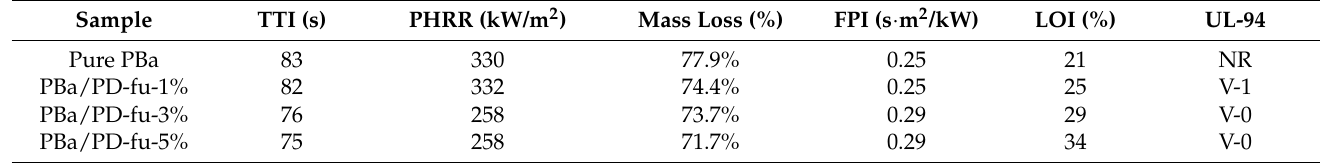
Table 3. CONE parameters and LOI results of PBa and PBa/PD-fu polymers.